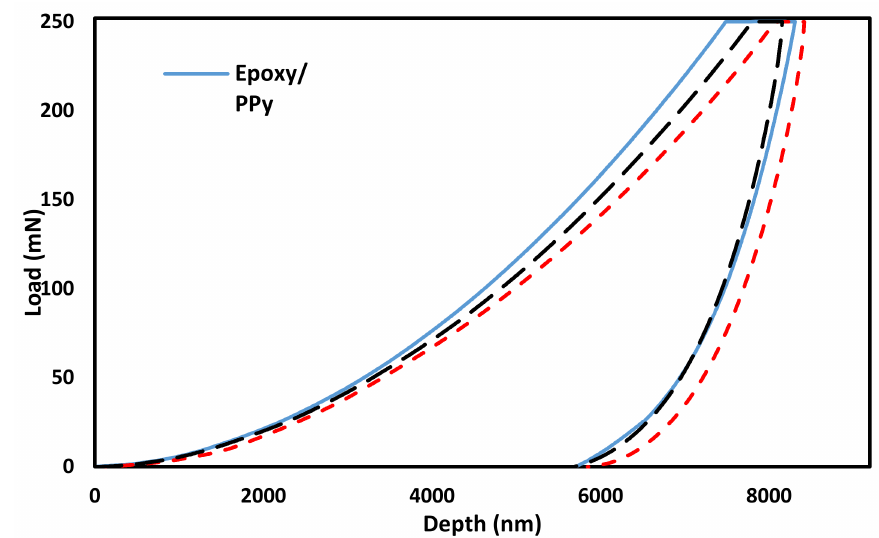
Figure 4. Nanoindentation load vs. depth graph for the fabricated epoxy / PPy, F1, and F2